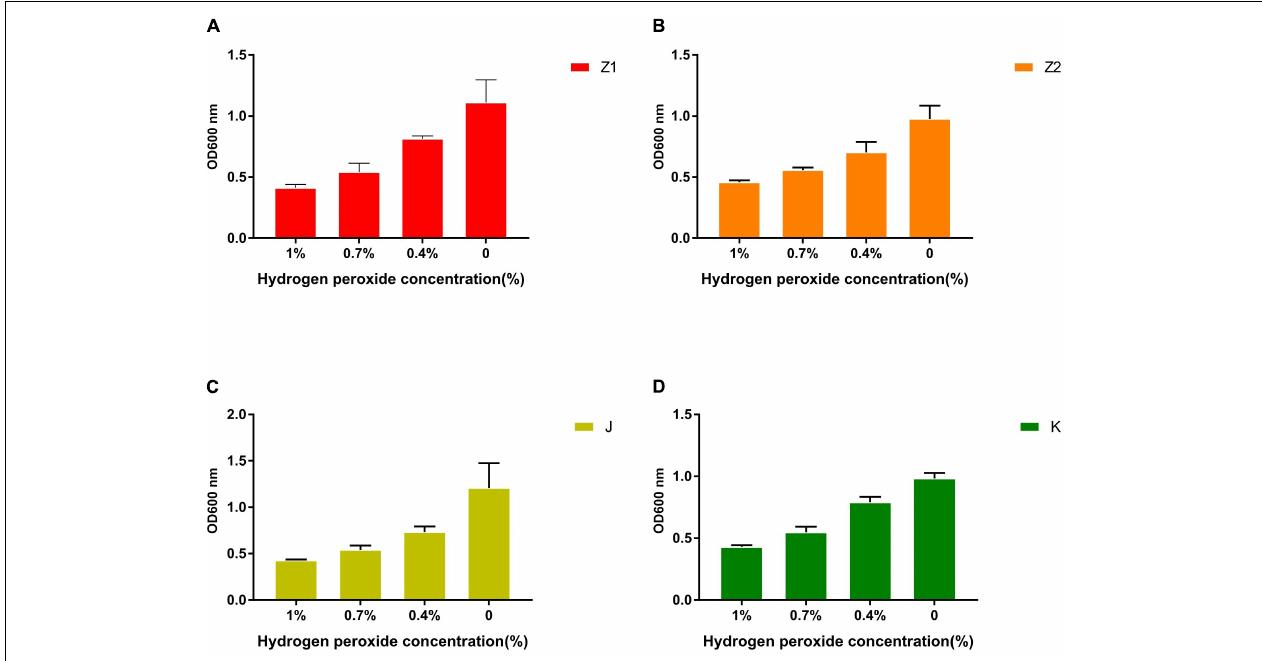
FIGURE 7 | The tolerance ability of all strains to 1, 0.7, 0.4, and 0% concentration of H 2 O 2 solution. (A) The result demonstrates the different concentrations of H 2 O 2 tolerance of Z1. (B) The result demonstrates the different concentrations of H 2 O 2 tolerance of Z2. (C) The result demonstrates the different concentrations of H 2 O 2 tolerance of J. (D) The result demonstrates the different concentrations of H 2 O 2 tolerance of